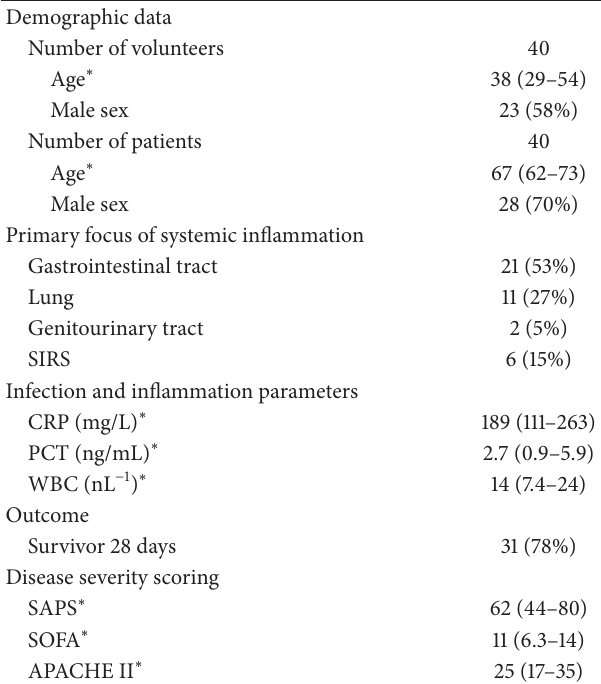
Table 1: Demographics and the clinical data of study